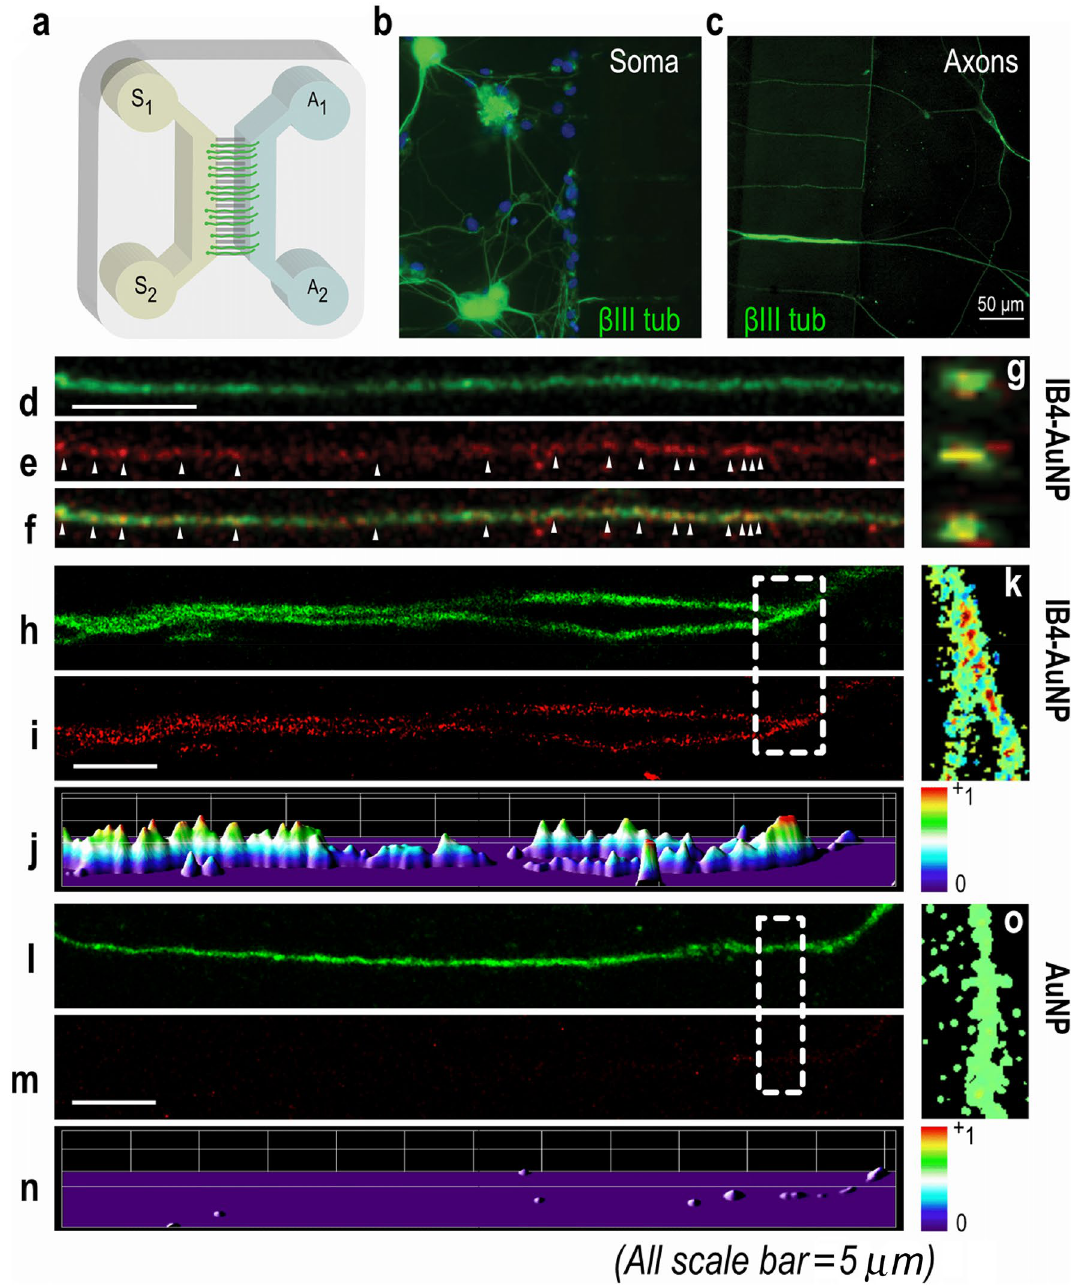
Figure 3. IB4-AuNP binds to axons of dissociated sensory neurons. Schematic representation of a microfluidic device (a) showing the soma (s1–2) and axonal (a1–2) compartments, with microgrooves in between. Confocal microscopy images of β-III tubulin stained dissociated rat DRG neurons cultured in the soma compartment (b) showing glial cells (blue) and sprouted axons that traversed the microgrooves and were observed in the axonal compartment (c) . Representative images of β-III tubulin stained axons (d) treated with IB4-AuNP, showing light scattering from AuNP (e) . Both signals from (d) and (e) , co-localized (arrows) at various locations on the axon (f) . Optical sections from (f) , showing co-localized signals (g) from within the axon. Colocalization colour map analysis of randomly selected axonal segments from IB4-AuNP treated devices (h–k) showing strong light scatter signals from within axons, while devices with non-functionalized AuNP (i–o) showed no light scatter. Experiments were performed in 3–4 devices per